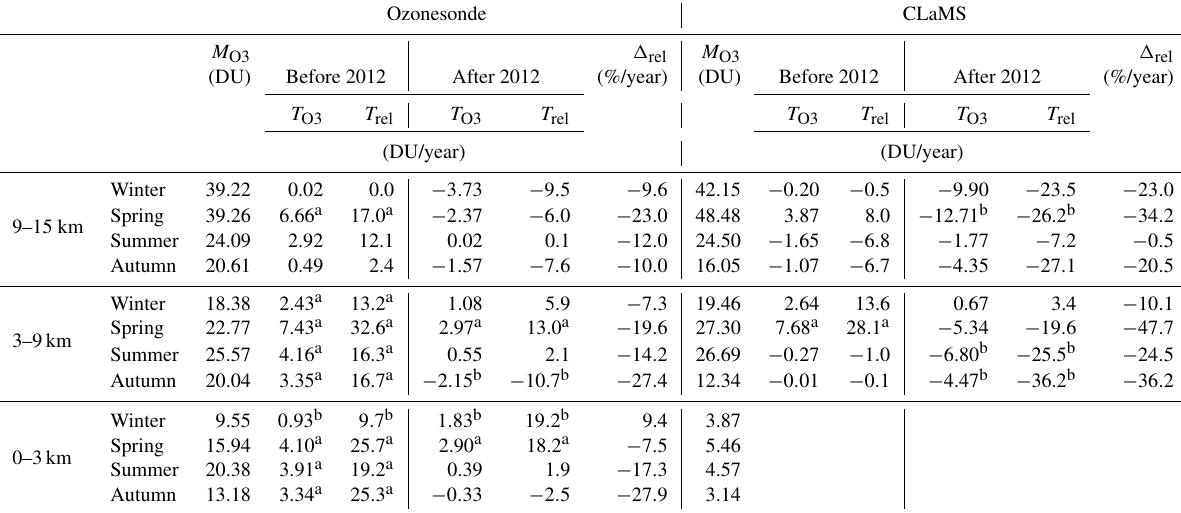
Table 1. Trends in the monthly mean partial column ozone at three altitudes in four seasons. Ozonesonde